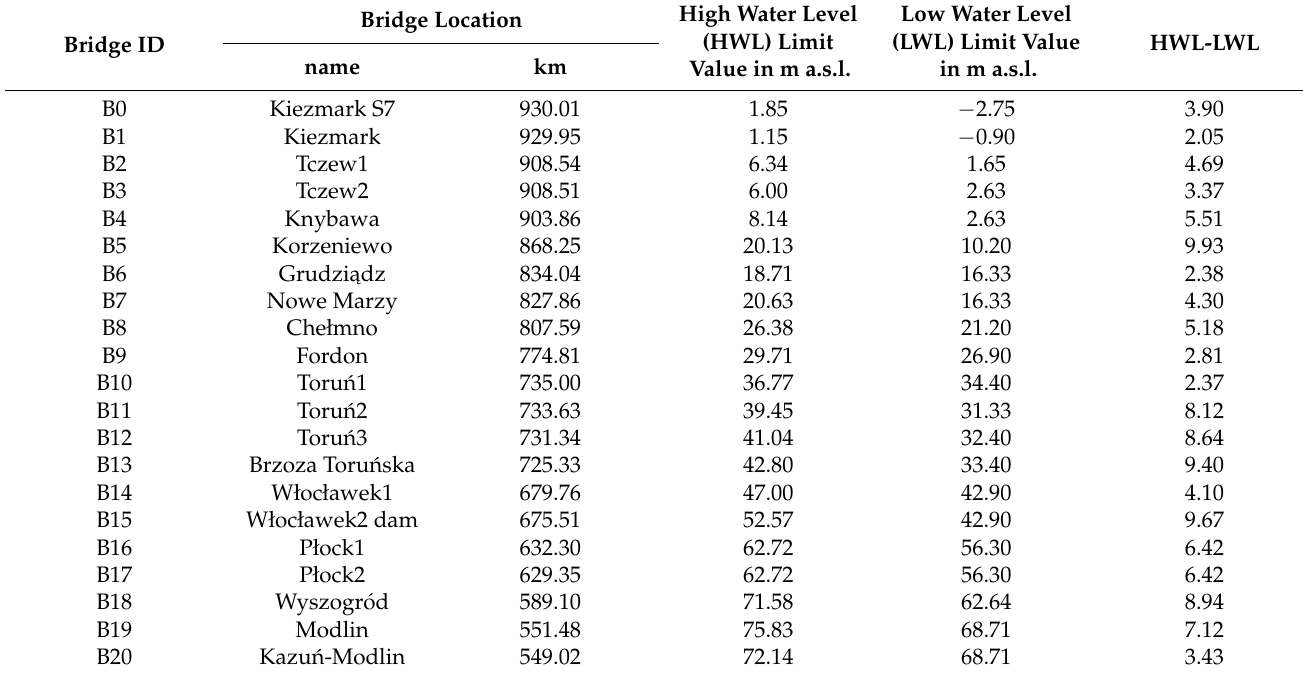
Table 3. Bridge structures existing on the Vistula River stretch from Gdansk to Warsaw and deter- mined vertical clearance and limit values for the high (HWL) and low (LWL) water for safe navigation. Bridge Bridge ID